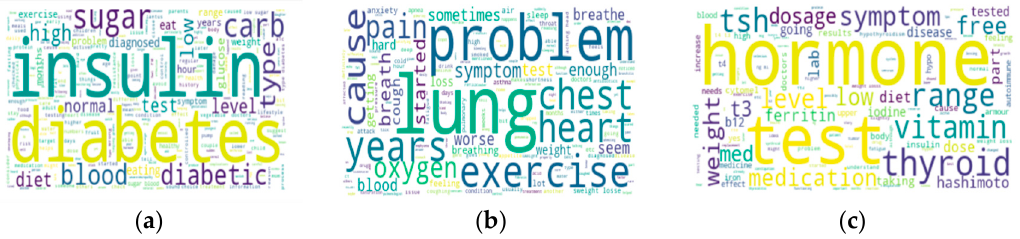
Figure 4. Visualization of keywords byword cloud: ( a ) DM, ( b ) TB and ( c ) thyroid.